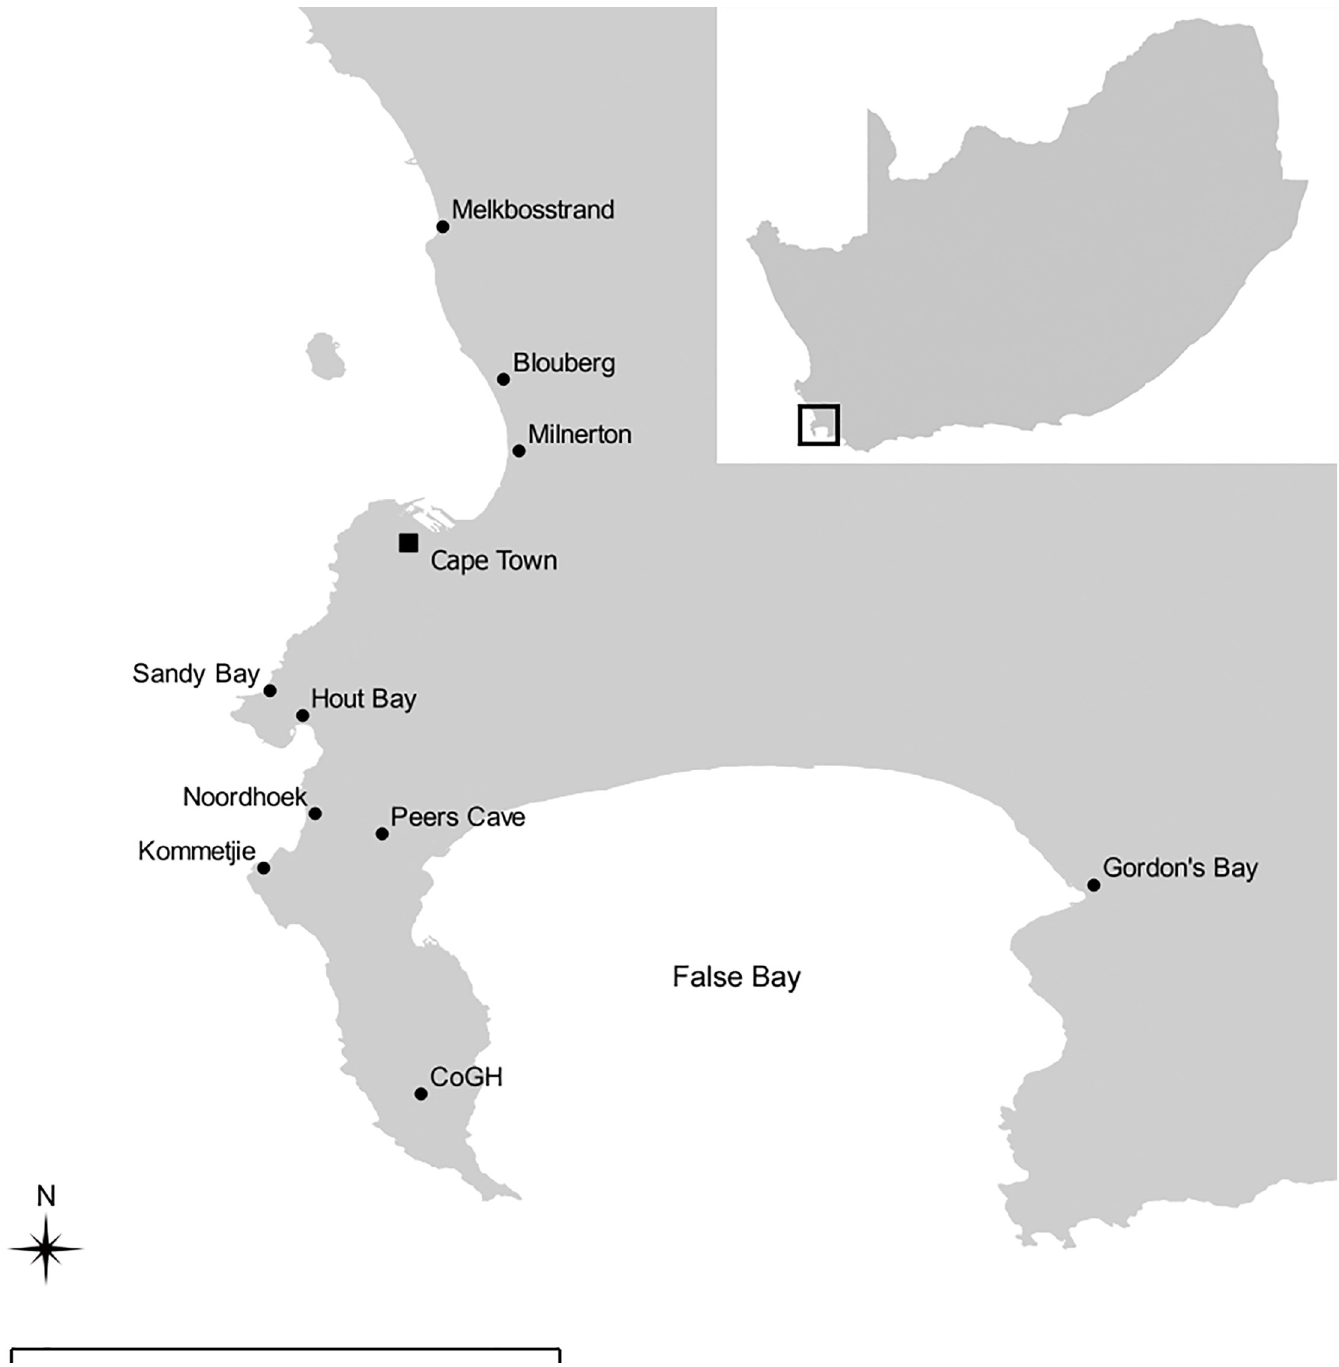
Fig 1. Map of study area showing locations mentioned in S1 Table (black circles). Scale bar = 20 km. CoGH = Cape of Good Hope section of the Table Mountain National Park. Inset: map of South Africa indicating location of area depicted by larger map (black square). Grey base shape file was obtained from the Municipal Demarcation Board of South